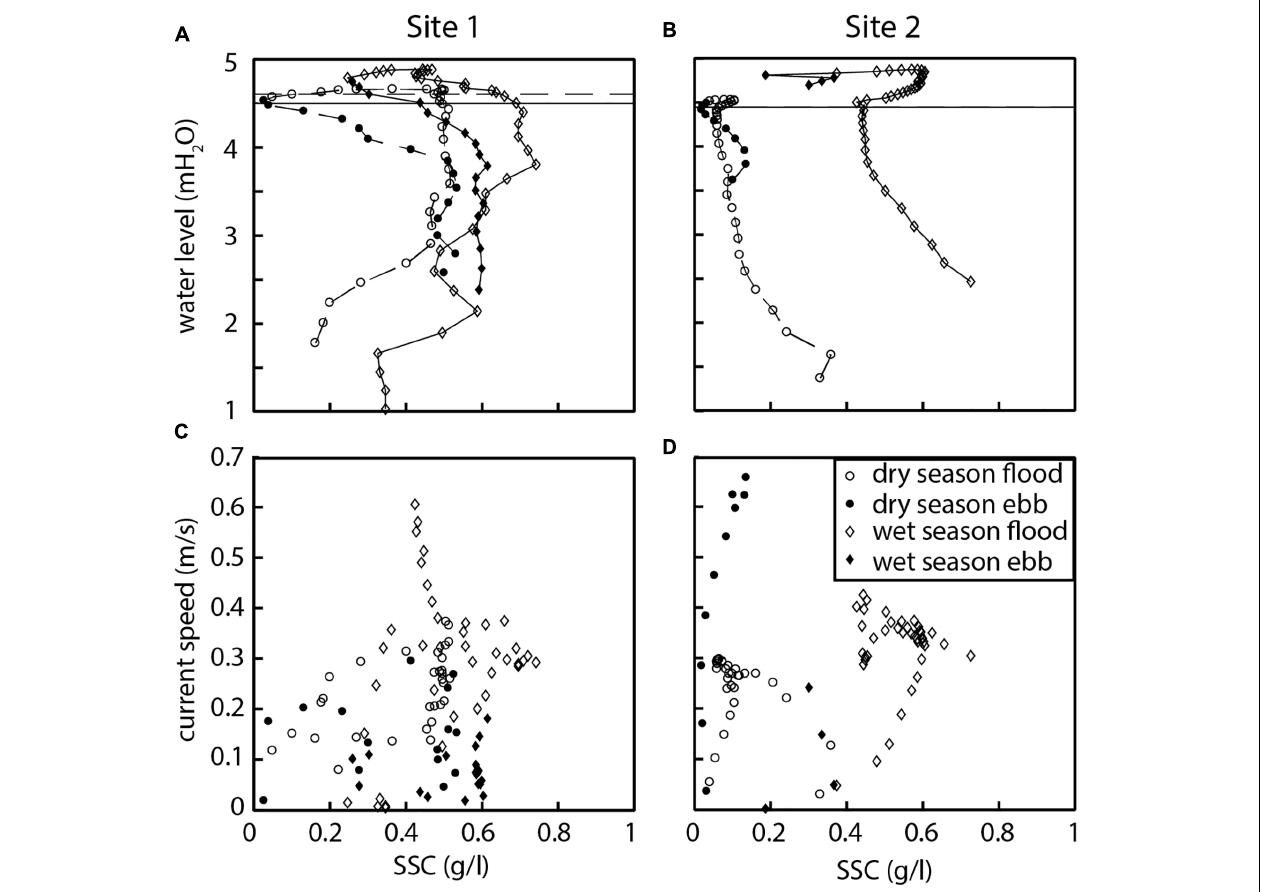
FIGURE 5 | Water level against tidal-channel SSC (A,B) and depth-averaged current speed against tidal-channel SSC (C,D) , for Site 1 (left) and Site 2 (right). SSC maxima occur immediately prior to inundation at Site 1, and near water-level minima at Site 2. SSC is generally higher during flood currents (open symbols), however, current speed is a poor predictor of SSC in either